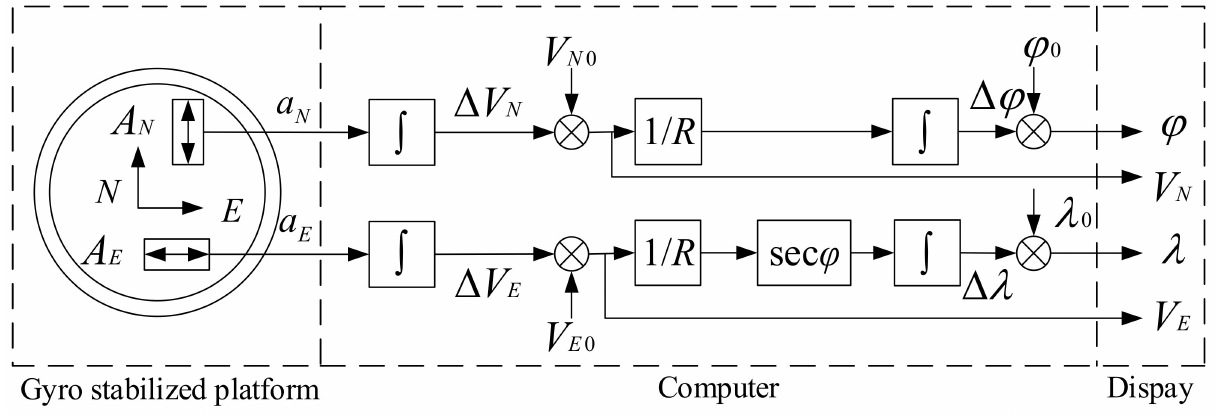
Figure 2. Simplified schematic of inertial